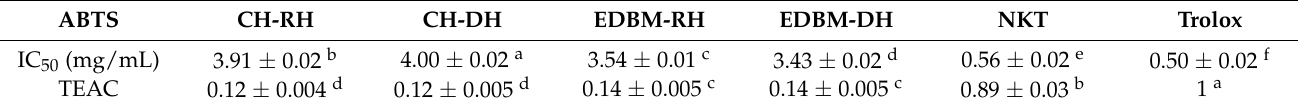
Table 5. IC 50 and TEAC coefficients of bovine hemoglobin hydrolysates for ABTS method.